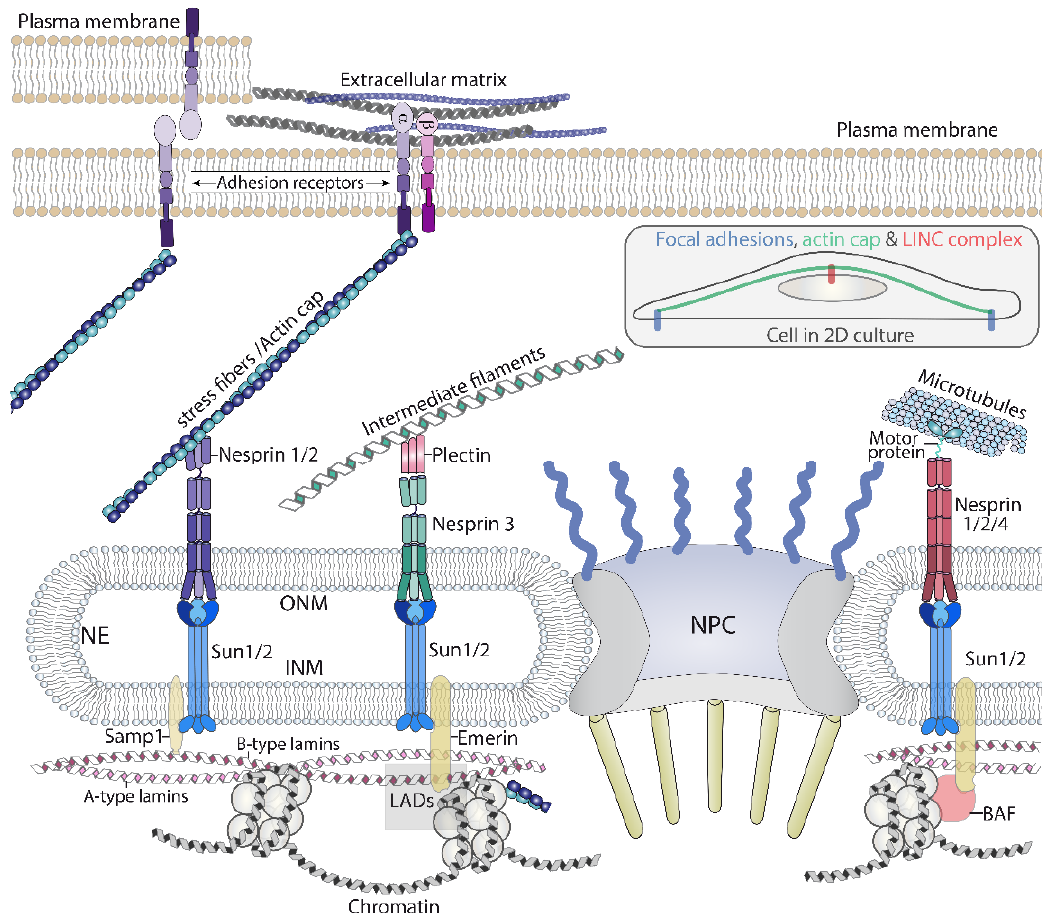
Figure 3. A graphical representation of the main components of the chain of macromolecular complexes that transmit forces, initiated outside the cell, to the nucleus. The LINC complex, through nesprins, connects with the three cytoskeletons, which permits the nucleus to sense forces generated or sensed by these polymers. LINC: linker of nucleoskeleton and cytoskeleton. NPC: Nuclear pore complex. ONM: Outer nuclear membrane. INM: inner nuclear membrane. LAD: Lamin associated domains. The inset illustrates the actin cap bound to focal adhesions and the LINC complex while crossing over the nucleus.